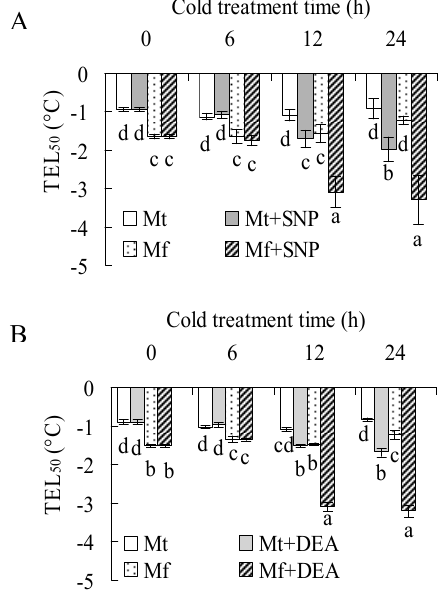
Figure 3. Cold tolerance in M. falcata (Mf) in comparison to M. truncatula (Mt) as affected by treatment with exogenous nitric oxide generators. Detached leaves of M. falcata and M. truncatula cv. A17 plants were treated with 200 µ M sodium nitroprusside (SNP, A ), 100 µ M diethylamine diethylammonium (Z)-1-(N,N-diethylamino) diazen-1-ium-1,2-diolate (DEA, B ), or H 2 O as a control. Ion leakage of leaves was measured to calculate the temperature that resulted in 50% lethality (TEL 50 ). Means of three replicates and standard errors are presented; the same letter above the column indicates no significant difference within each day at p <